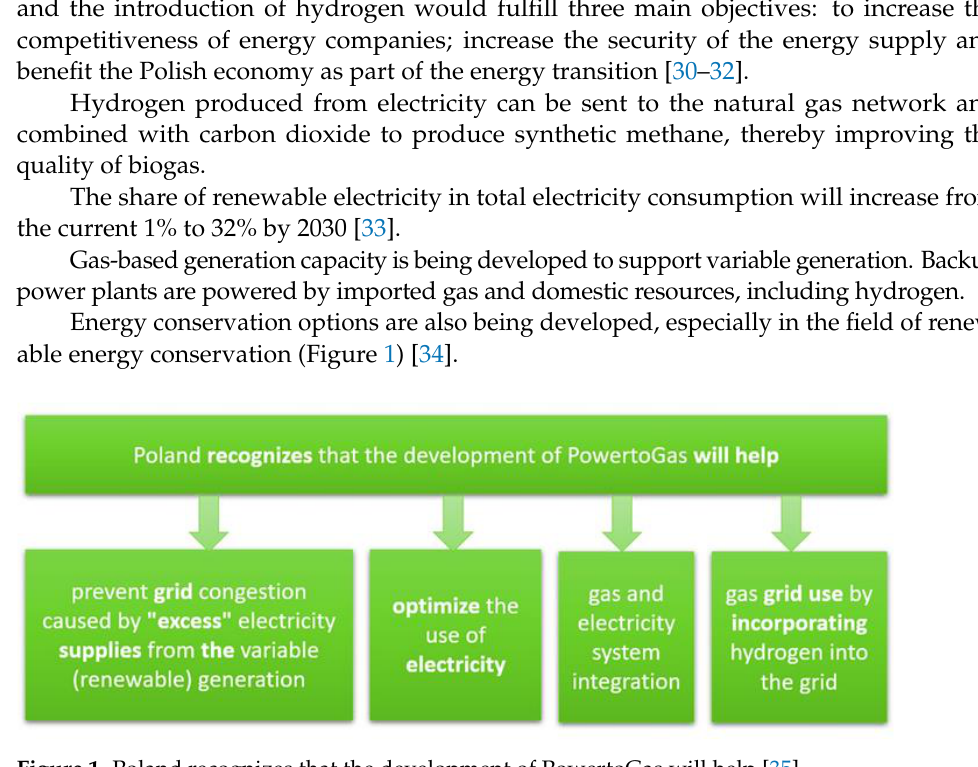
Figure 1. Poland recognizes that the development of PowertoGas will help [35] .